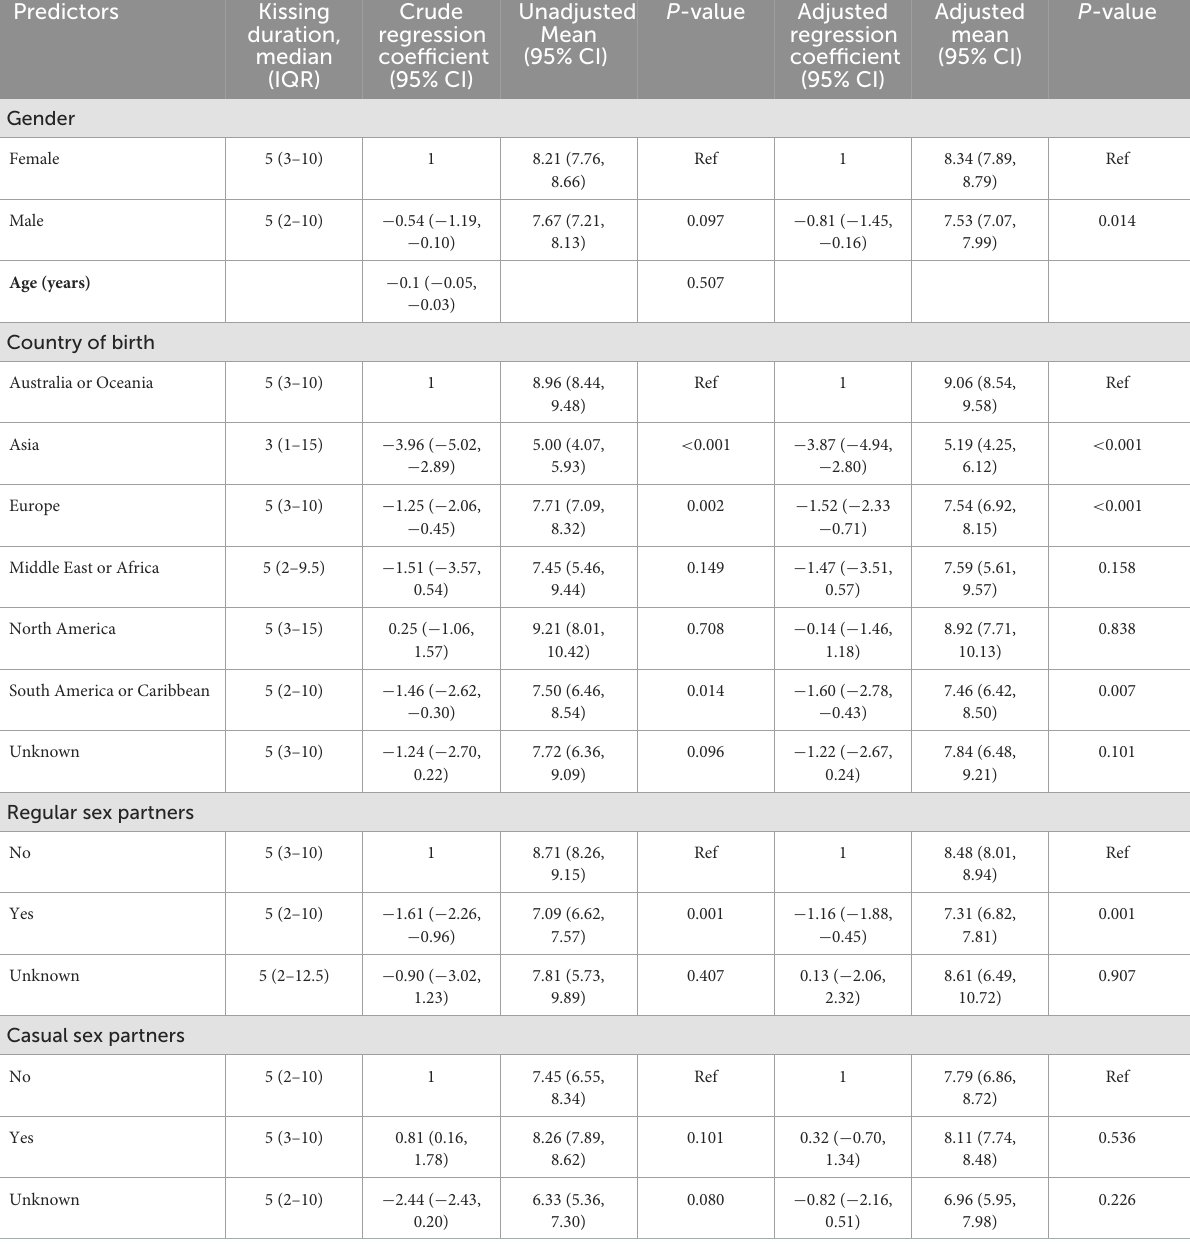
TABLE 4 Univariable and multivariable linear regression analyses of the association between demographic factors and the duration of kissing while lying down underneath partner among 2,199 heterosexual men and women who had opposite-gender kissing partners in the past 3 months. Predictors Kissing